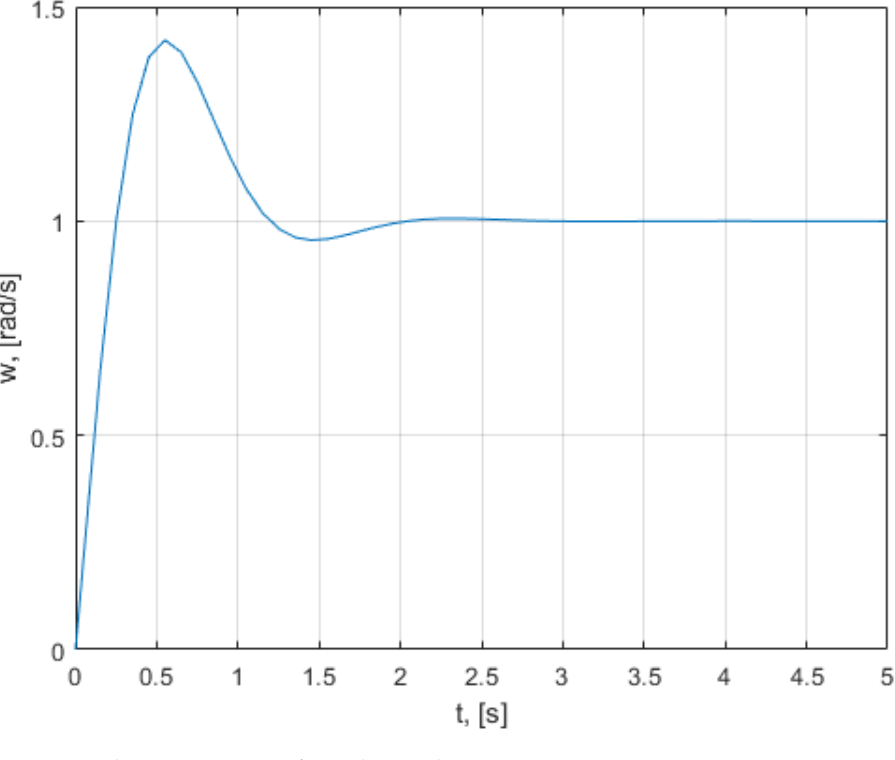
Figure A1. The step response of speed control system.